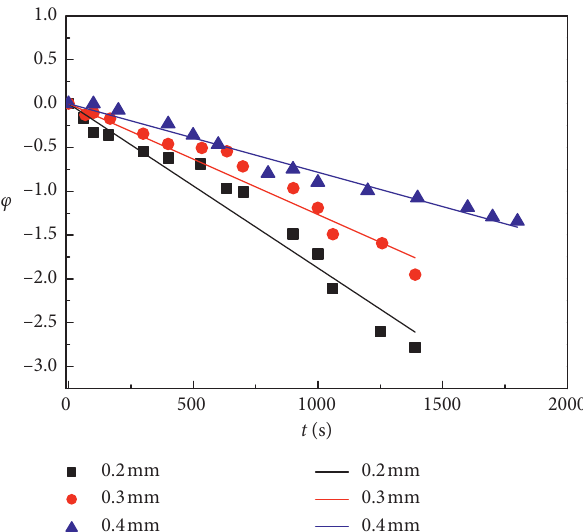
Figure 10: The retraction of PP fibers with a diameter of 0.2mm, 0.3mm, and 0.4 mm in the POE sheets. The symbols denote the experimental data, and the lines are obtained by data fitting.